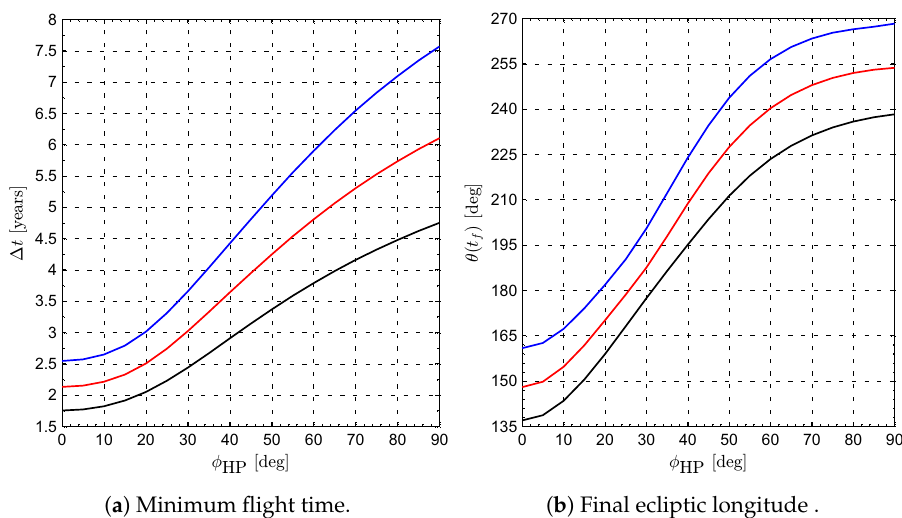
Figure 9. Minimum flight time and final ecliptic longitude as a function of the HP ecliptic latitude in a three-dimensional mission scenario with r HP = 2.5au → black line, r HP = 3au → red line, and r HP = 3.5au → blue line.